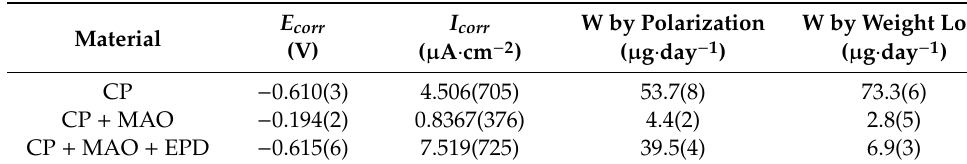
Table 5. Estimated from Tafel extrapolation corrosion potential ( E corr ) and current ( I corr ) with calculated weight loss form Faraday law (W by polarization) and after 14-days immersing in Ringer solution environment (W by weight loss) of Ti23Mo alloys obtained by different processing approaches.